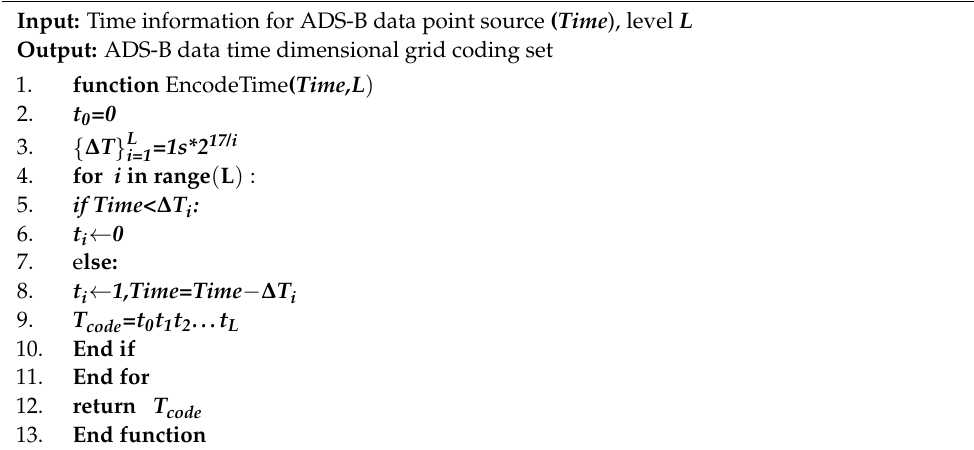
Algorithm 3 Grid set generation algorithm for